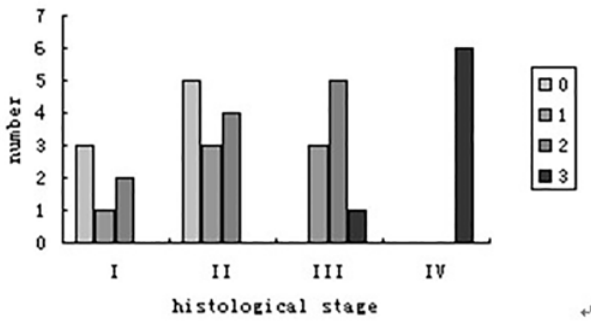
Fig 10. Halo sign grade at different histological